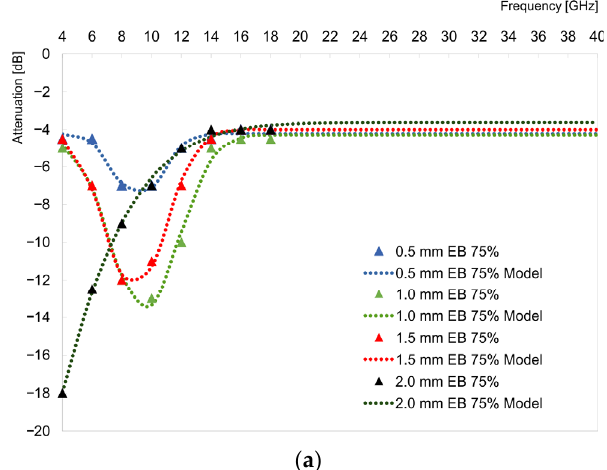
Table 4. Results of fi tt ing the model curve (Gaussian) to the measurement